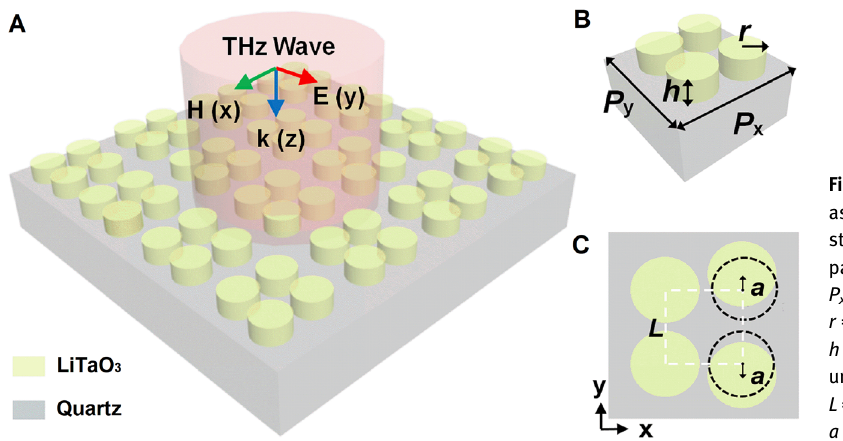
Figure 1: (A) Schematic of the THz asymmetric all-dielectric metasurface structure. (B) Unit cell with the geometric parameters. The lattice constant is P x = P y = P = 63 μ m, the cylinder radius is r = 11 μ m, and the cylinder height is h = 11 μ m. (C) Top view ( x – y plane) of the unit cell. The distance between cylinders is L =26 μ m,andtheasymmetricparameteris a = 0.4 μ